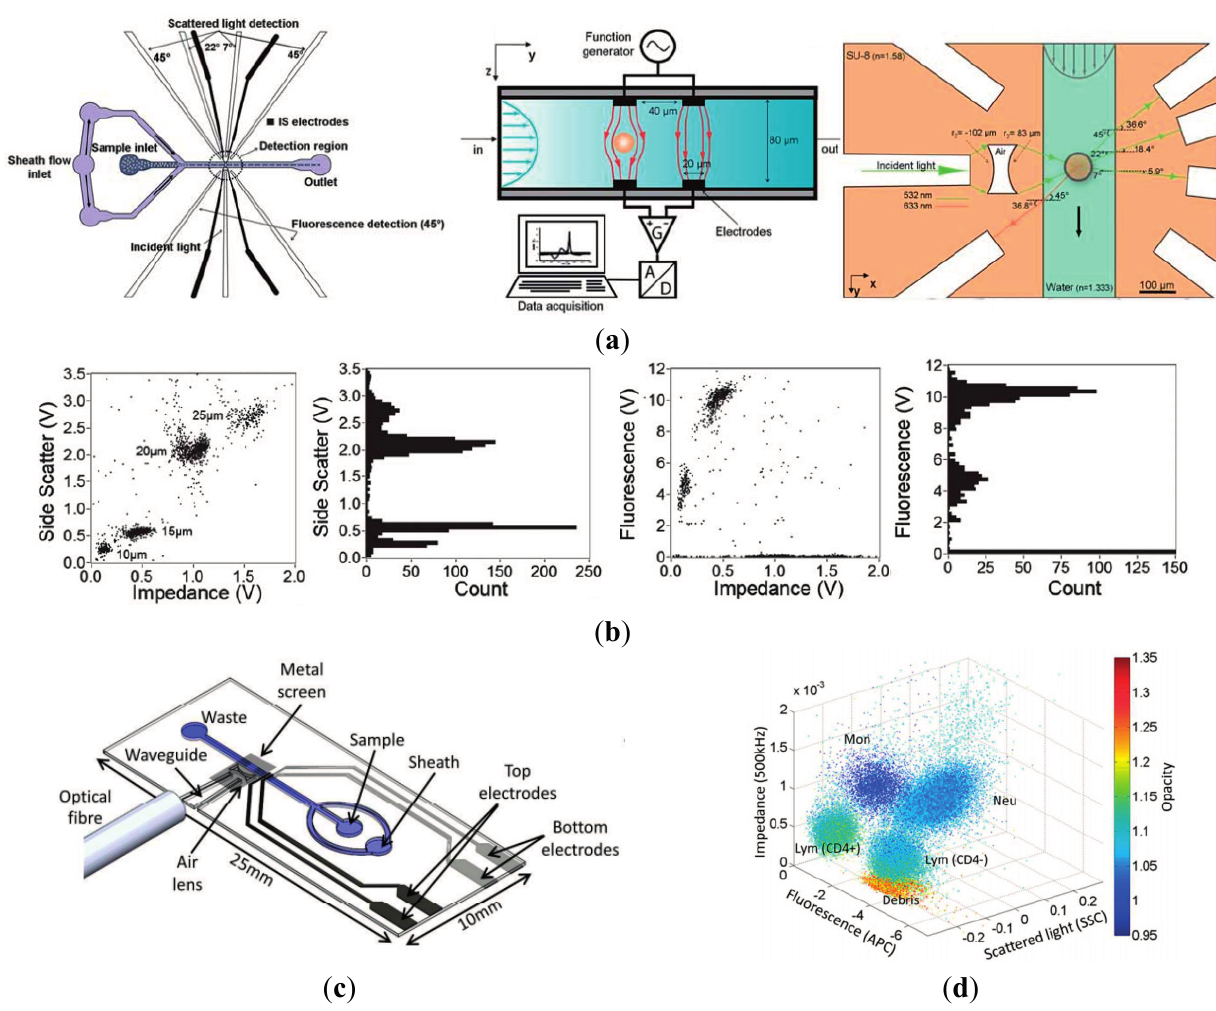
Figure 7. ( a ) The second-generation microfluidic impedance and fluorescent flow cytometry with on-chip optical components where a groove in SU-8 holds a fiber to launch incident light, which is then focused into the channel using an air compound lens. Fibers at various angles are used to collect fluorescence emission, optical extinction signal loss, and side scattered light, respectively; ( b ) Side scattered light, fluorescence and impedance data based classification of a mixture of different beads (10 and 15 μ m diameter fluorescent, 20 and 25 μ m diameter plain); ( c ) A new microfluidic impedance and fluorescent flow cytometry with on-chip waveguides in a sheath-less manner, which can effectively address misalignment of the optical fibers, incident light scatter from multiple interfaces and signal dependent on particle positions; ( d ) The 3-D scatter plot for CD4 labelled white blood cells based on parameters of side scatter light, fluorescence, and two-frequency impedance data. Both side scattered light and low frequency impedance data provide information on cell sizes, which discriminate smaller lymphocytes from granulocytes. High-frequency impedance data discriminates monocytes from neutrophils due to differences in cell membrane capacitance while CD4 labelled white blood cells were distinguished from white blood cells without CD4 labelling based on fluorescent data